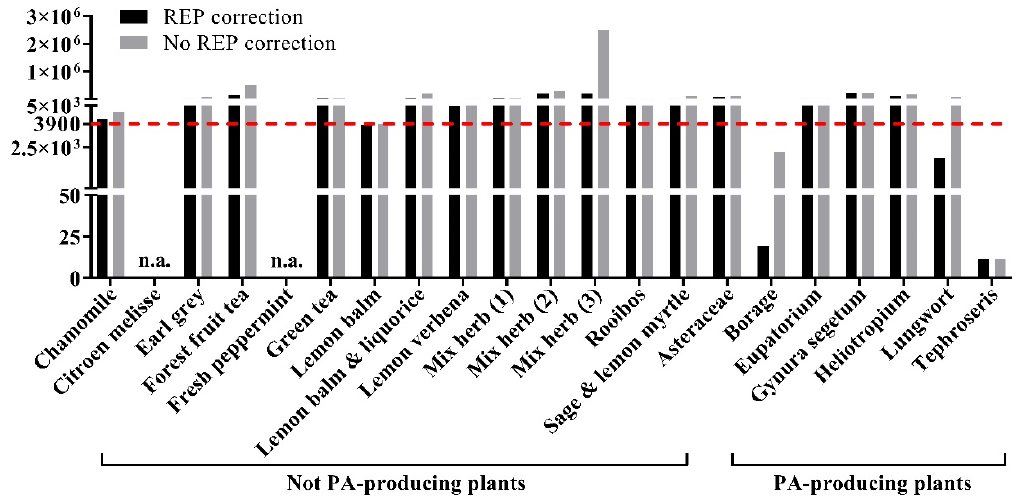
Figure 2. The maximal number of weeks during a 75-year lifetime that a (herbal) tea investigated in this study could be consumed to result in an MOE of 10,000, given that daily intake is one cup of tea. Black bars represent the number of weeks obtained based on the total PA levels corrected by the REP factors, while grey bars represent the values without REP correction. The red dashed line represents a 75-year lifetime (equivalent to 3900 weeks). n.a. indicates that the data are not applicable.